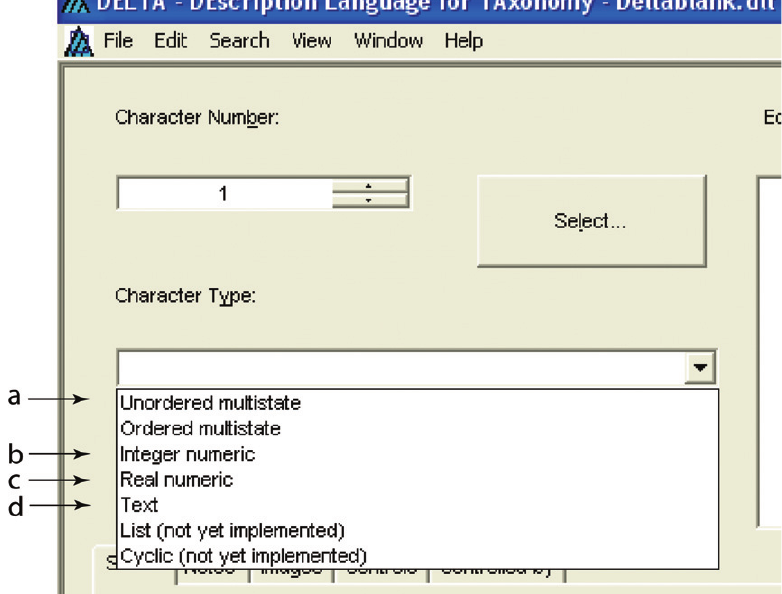
Figure 5a–d. Character types selection from the Character